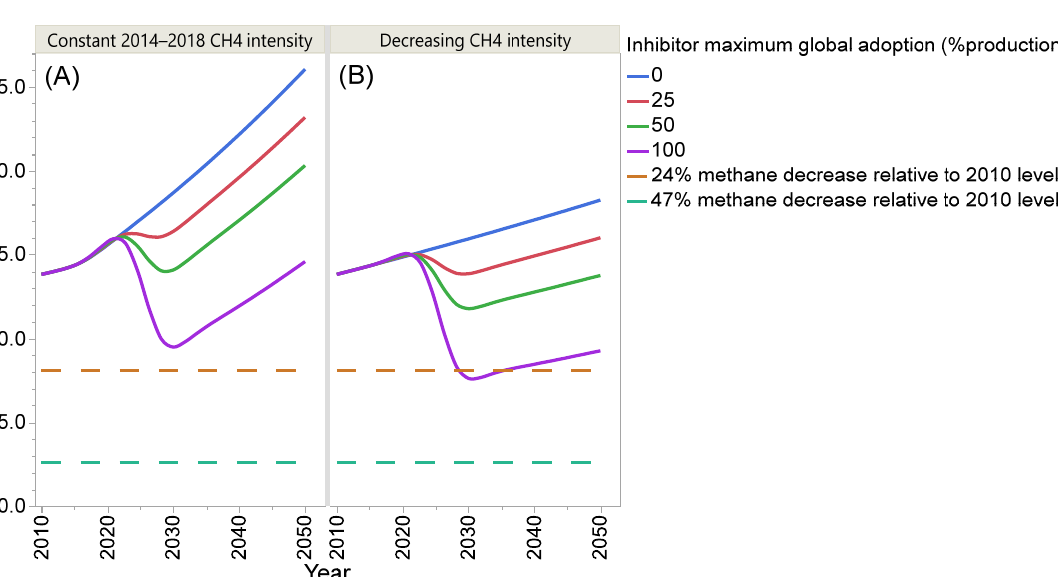
Figure 2. Predicted evolution of enteric methane (CH 4 ) emissions from global lamb production between 2010 and 2050 considering ( A ) constant CH 4 intensity and ( B ) declining CH 4 intensity according to Table 1. Adoption of feed additive inhibitors of methanogenesis decreasing CH 4 intensity by 26.6% is simulated to occur at 0, 25, 50, or 100% of global lamb production. Decreases in enteric CH 4 emissions of 24 and 47% relative to 2010 required to maintain a global temperature increase within 1.5 °C according to different socioeconomic scenarios and climate models [15] are shown in dashed lines.